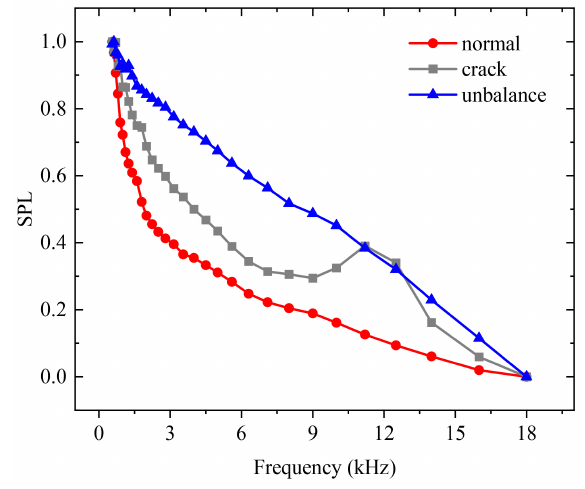
Figure 11. The 1/6-octave feature of different types of defects.